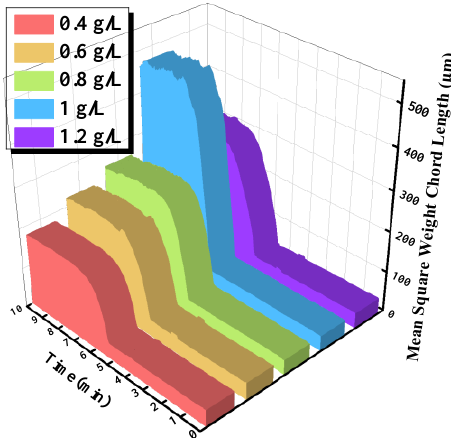
Figure 6. Weighted trend of the average diameter of kaolinite suspension with different concentrations of PEO.